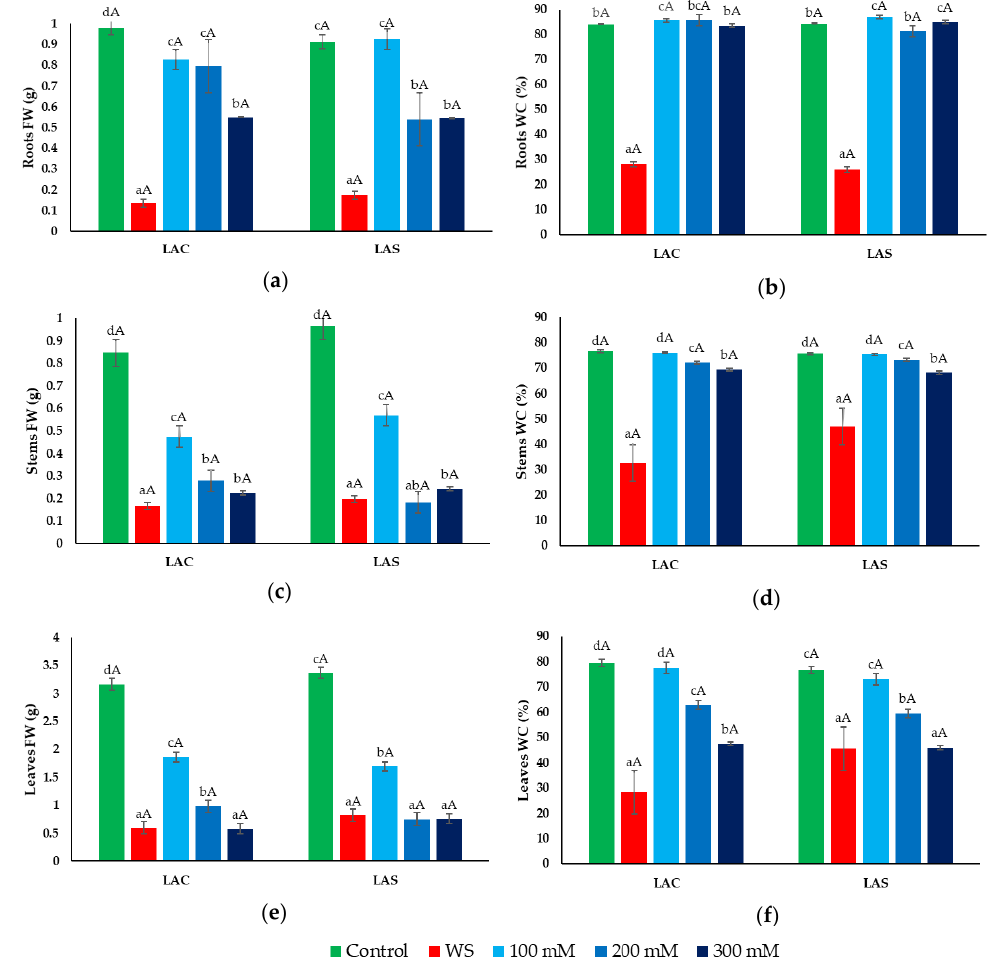
Figure 3. E ff ect of water and salt stress treatments on growth parameters in L. angustifolia var. ‘Codreanca’ (LAC) and var. ‘Sevtopolis’ (LAS). Fresh weight (FW) ( a , c , e ) and water content percentage (WC%) ( b , d , f ) of roots ( a , b ), stems ( c , d ) and leaves ( e , f ) of lavender plants after 30 days of growth under control conditions, in the presence of the indicated NaCl concentrations or subjected to water stress (WS) (completely withholding irrigation). Bars represent means ± SE ( n = 5). Di ff erent lowercase letters above the bars indicate significant di ff erences between treatments for each variety, and di ff erent uppercase letters indicate significant di ff erences between the two varieties for plants undergoing the same treatment, according to the Tukey test ( α = 0.05).